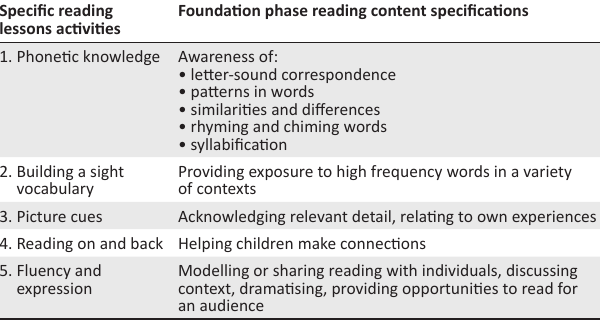
TABLE 1: Reading activities adapted from the policy on